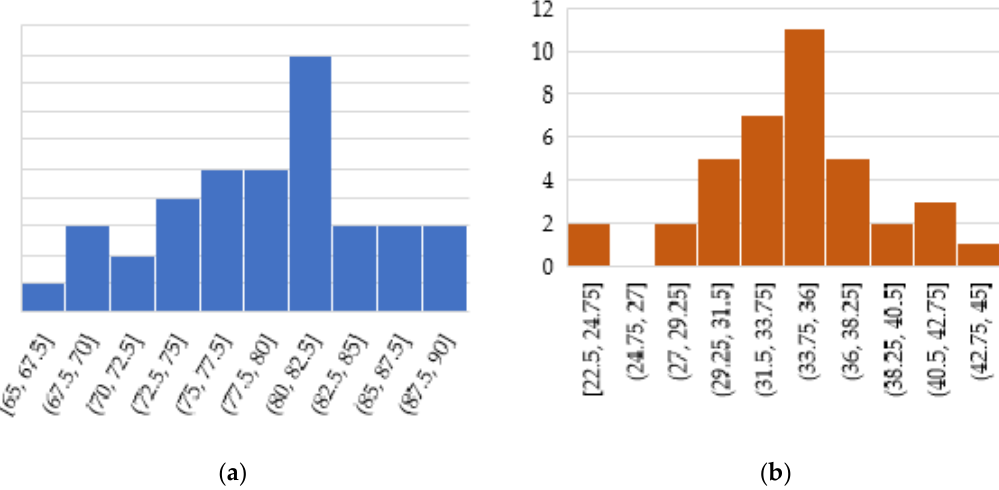
Figure 9. Histogram for the system usability scale (SUS) score of Clockchain ( a ) with middleware and ( b ) without middleware.